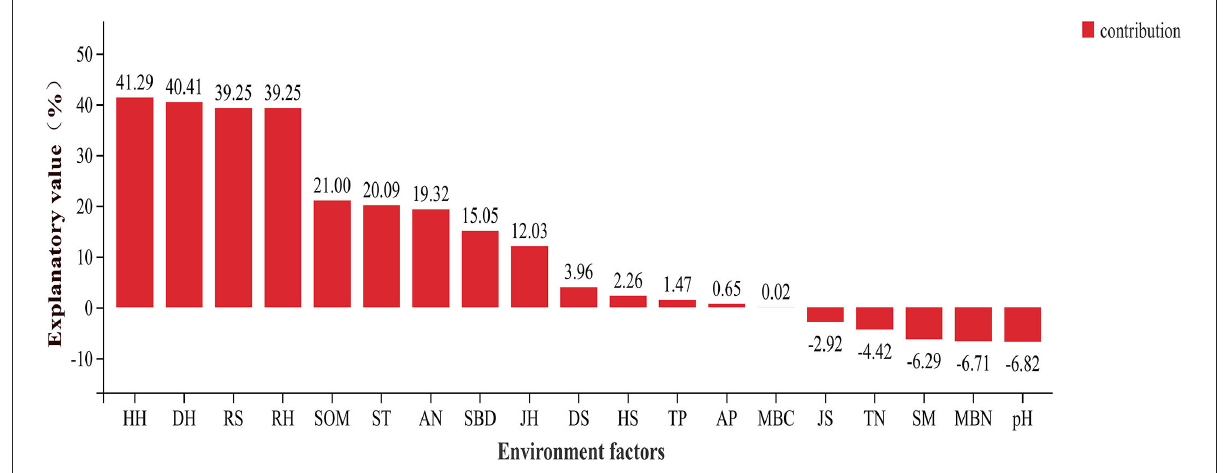
FIGURE5 Variance partitioning analysis (VPA) of dominant phyla of soil bacteria and environmental